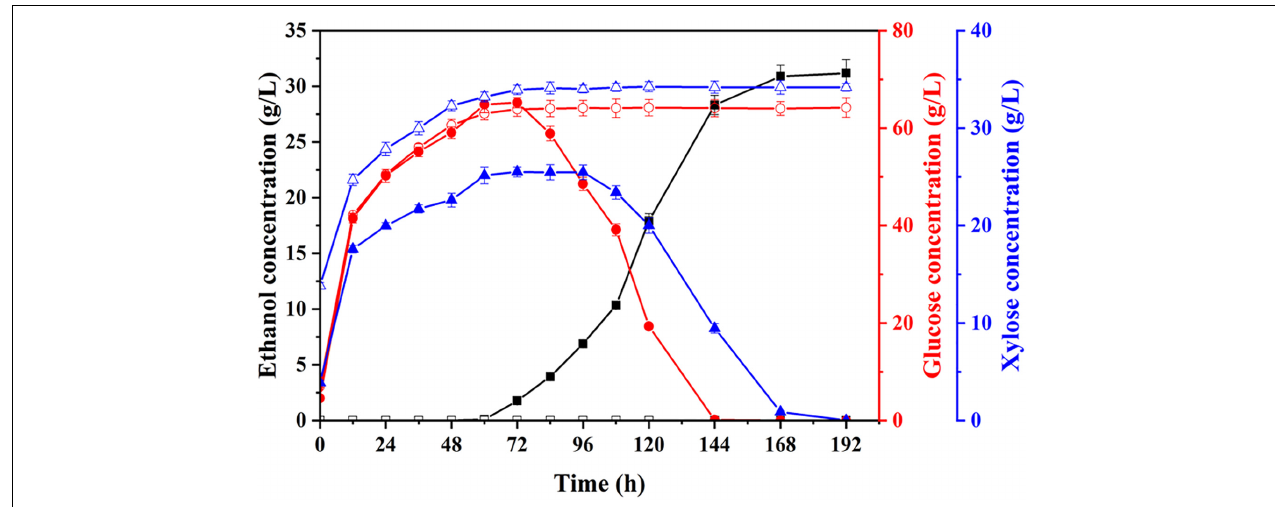
FIGURE 2 | Changes in concentrations of ethanol, glucose, and xylose during fermentation of pretreated corn fiber by dilute acid under different pretreatment conditions for assessing inhibitors’ effect on fermentation. Ethanol, square; glucose, circle; xylose, triangle; pretreatment with 0.5% H 2 SO 4 at 105 ◦ C for 43 min, solid; and pretreatment with 0.5% H 2 SO 4 at 125 ◦ C for 35 min, hollow.